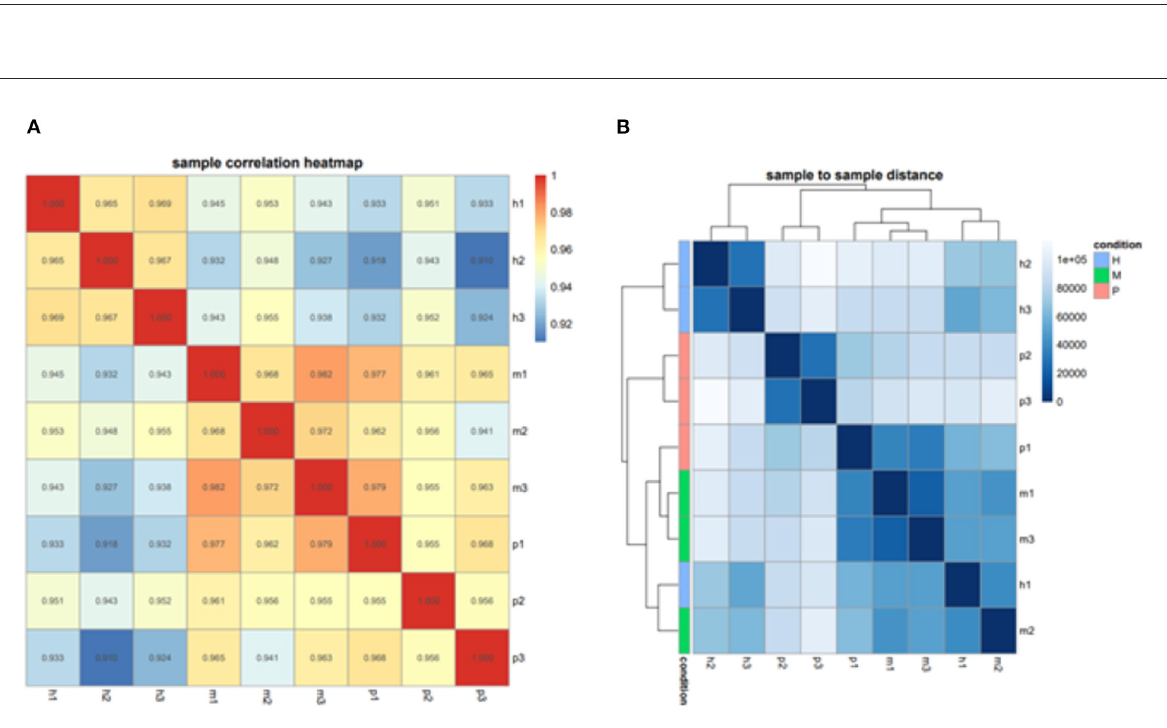
FIGURE4 The correlation and distance among nine samples. (A) Sample correlation heatmap of nine samples, each small square represents the correlation between each sample of horizontal and vertical coordinates. The larger the correlation coefficient, the closer the color is to red. (B) Sample to sample distance heatmap of nine samples, each small square represents the distance between each sample of horizontal and vertical coordinates. The farther the samples are, the lighter the